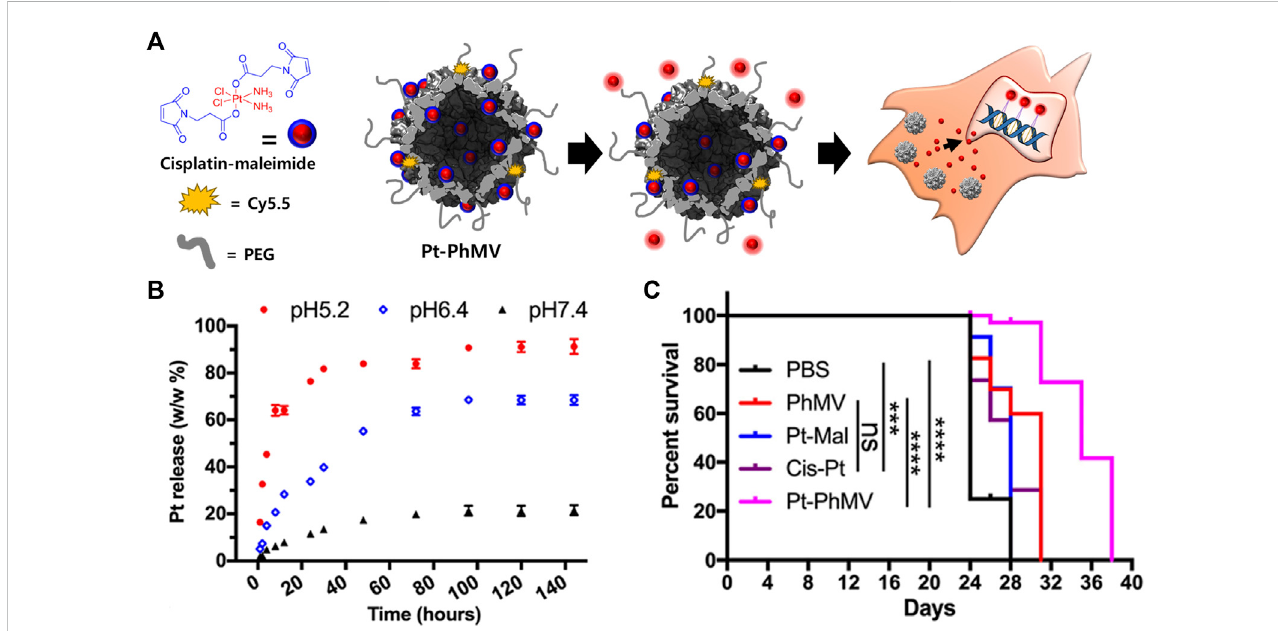
FIGURE 2 (A) Schematic illustration of synthesizing Pt-loaded and PEGylated PhMV VLPs (Pt-PhMV) for cancer therapy. (B) The pH-dependent controlled release pro fi le of Pt from Pt-PhMV. (C) Survival of an athymic mouse model with MDA-MB-231 xenografts after treatment with Pt-PhMV. Reprinted with permission from Hu and Steinmetz (2020b). Copyright (2020) American Chemical